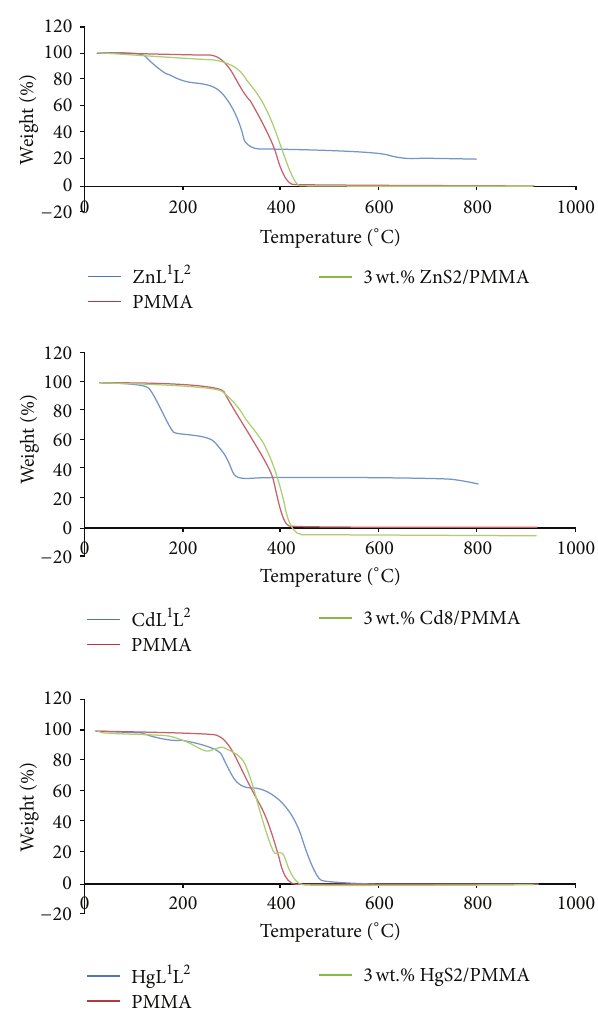
Figure 3: TGA curves for ML 1 L 2 precursor complex, pure PMMA, and their MS2/PMMA nanocomposites. M = Zn, Cd, and